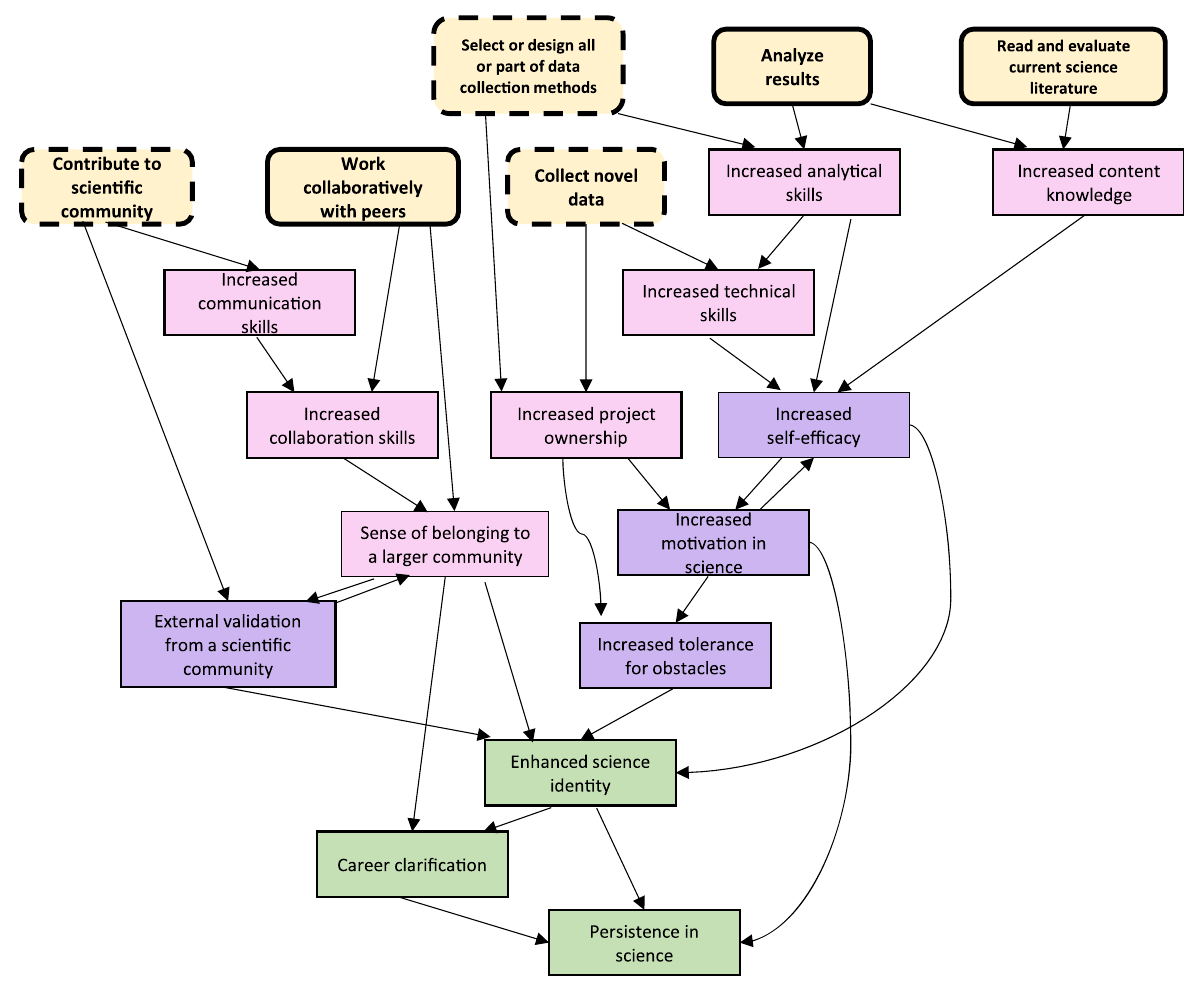
FIG. 1. Modified version of CURE pathway model posited in Corwin et al. [7]. Activities students participate in are represented by yellow, curved rectangles. Short-term, medium-term, and long-term outcomes under study are represented with pink, purple, and green boxes, respectively. Arrows represent relationships between activities and outcomes, and feedback loops between two outcomes are shown by arrows pointing in both directions between outcomes. In RBSEU CUREs, students participated in all of the activities. In RBSEU QCUREs, students participated in only those activities with a continuous outline, not those with a dashed outline. Previous research on CUREs has suggested that outcomes represented in this figure are either probable (including increased self-efficacy), meaning multiple studies support the expectation of this outcome, or possible (including increased motivation in science, and sense of belonging to a larger community), meaning only a few studies currently support expectation of this outcome